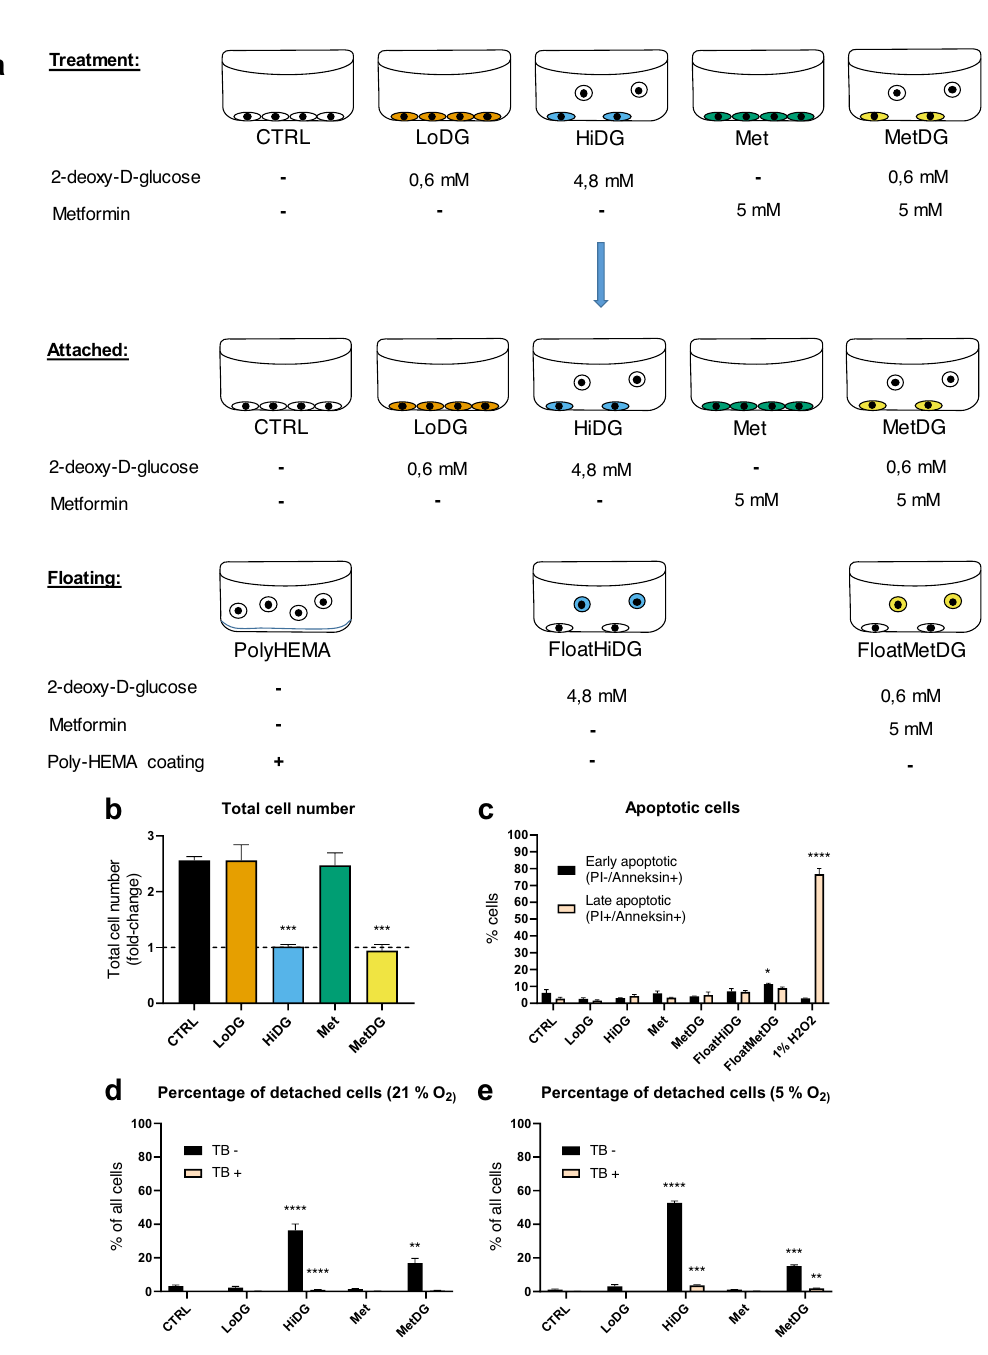
Figure 1. Schematic representation of the treatments ( a ), proliferation ( b ) and viability ( c ) of cell for metabolic profiling. MDA-MB-231 cells were treated for 48 h with metformin and/or 2-deoxy-D-glucose (2DG) with daily medium change. For treatments that induce cell detachment, attached and detached populations were harvested and analyzed separately. Untreated cells grown on poly-HEMA were used as an additional control for floating cells ( a ). Floating and attached cells were counted separately with Countess cell counter and the total cell number (attached + floating) per treatment normalized to the number of seeded cells is presented. The mean ± SEM is shown for three independent experiments ( b ). Cell viability was determined with annexin/PI staining using flow cytometry. The percentage of early apoptotic (annexin+/PI−) and late apoptotic (annexin+/PI+) cells is shown as mean ± SEM for two independent experiments. 1% H2O2 treatment for 1 h was used as positive control ( c ). Cell detachment was separately characterized at atmospheric (21%) and physiological (5%) O2 levels. Cells were treated for 48 h either at 21% O 2 with daily medium change ( d ) or in a surplus of medium at 5% O 2 ( e ) and the number of attached and detached cells counted with Trypan blue staining. The mean percentage of detached cells ± SEM is shown for three to six ( d ) or two ( e ) independent experiments. CTRL—attached untreated control cells, LoDG—0.6 mM 2DG treated attached cells, HiDG—attached 4.8 mM 2DG treated cells, Met—attached 5 mM metformin treated cells, MetDG—attached 5 mM metformin + 0.6 mM 2DG treated cells, FloatHiDG—floating detached 4.8 mM 2DG treated cells, FloatMetDG—floating detached 5 mM metformin + 0.6 mM 2DG treated cells, poly-HEMA—floating untreated cells grown on poly-HEMA. * p < 0.05, ** p < 0.01, *** p <